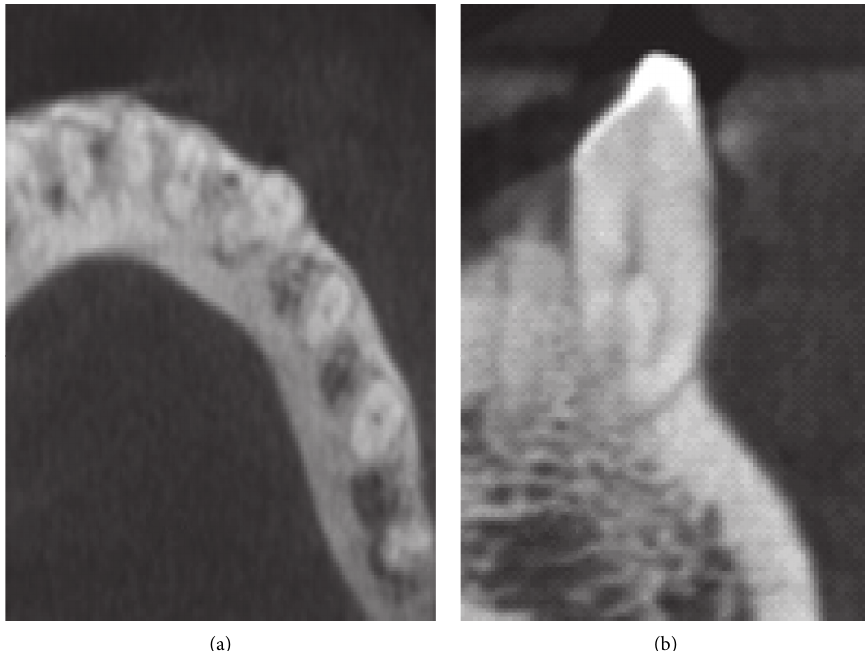
Figure 1: Cone-beam computed tomography image for mandibular canine with two roots. (a) The axial plane. (b) The coronal plane.